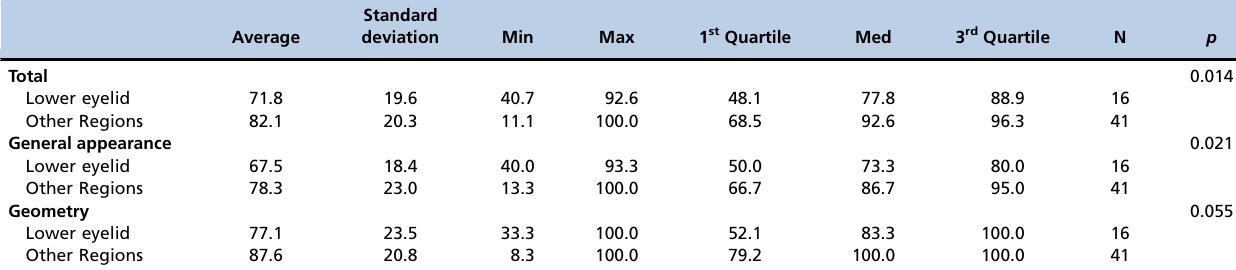
Table 5 - Summary measures of facial satisfaction factors by procedure location - lower